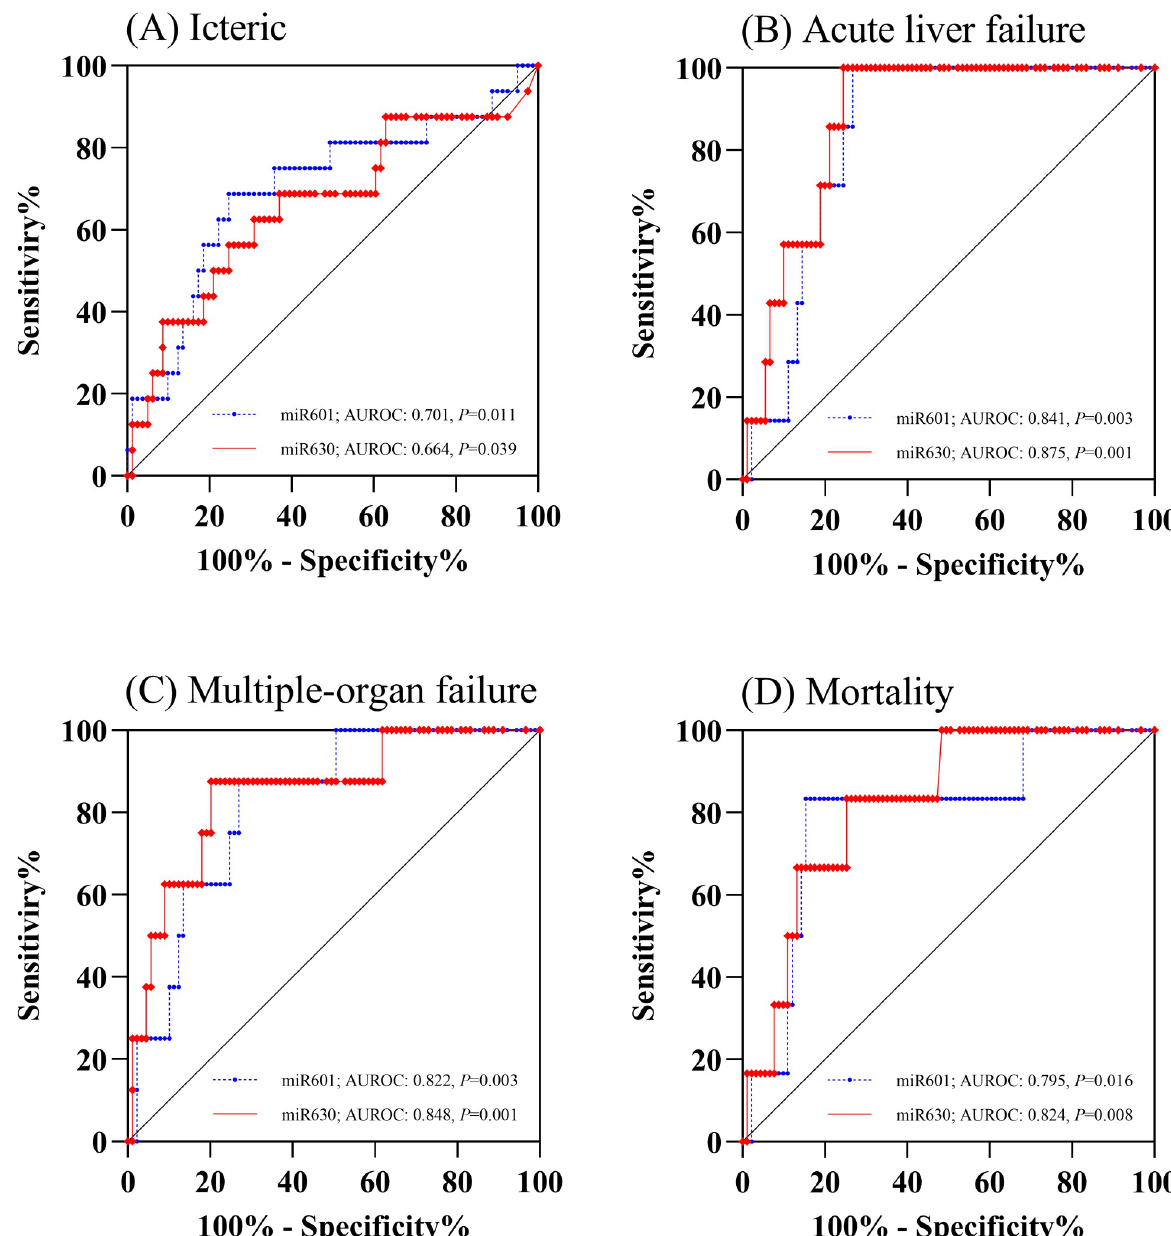
Fig 3. ROC curve analysis of serum miR-601 and miR-630 for icteric status (A), acute liver failure (B), multiple organ failure (C), and mortality (D).